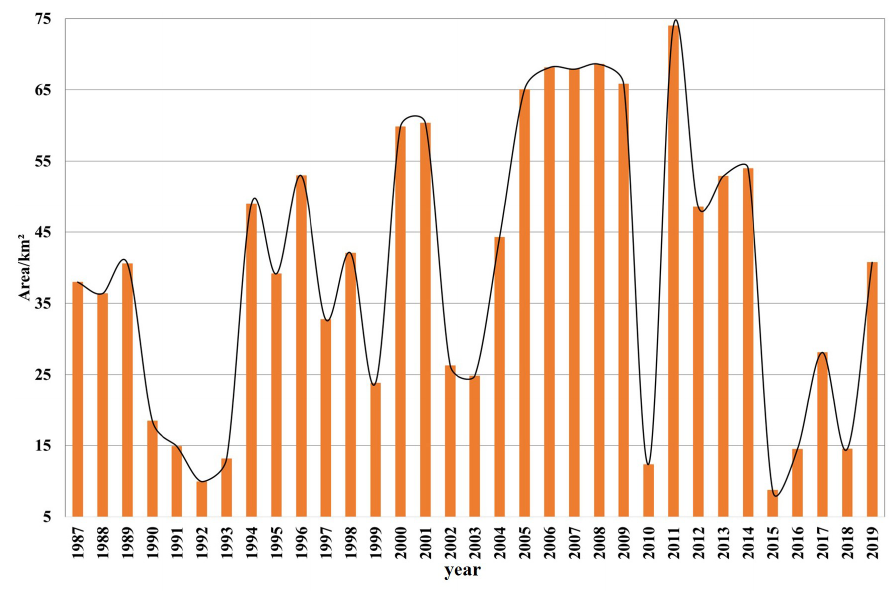
Figure 9. Aquatic vegetation area of Longgan Lake from 1987 to 2019.